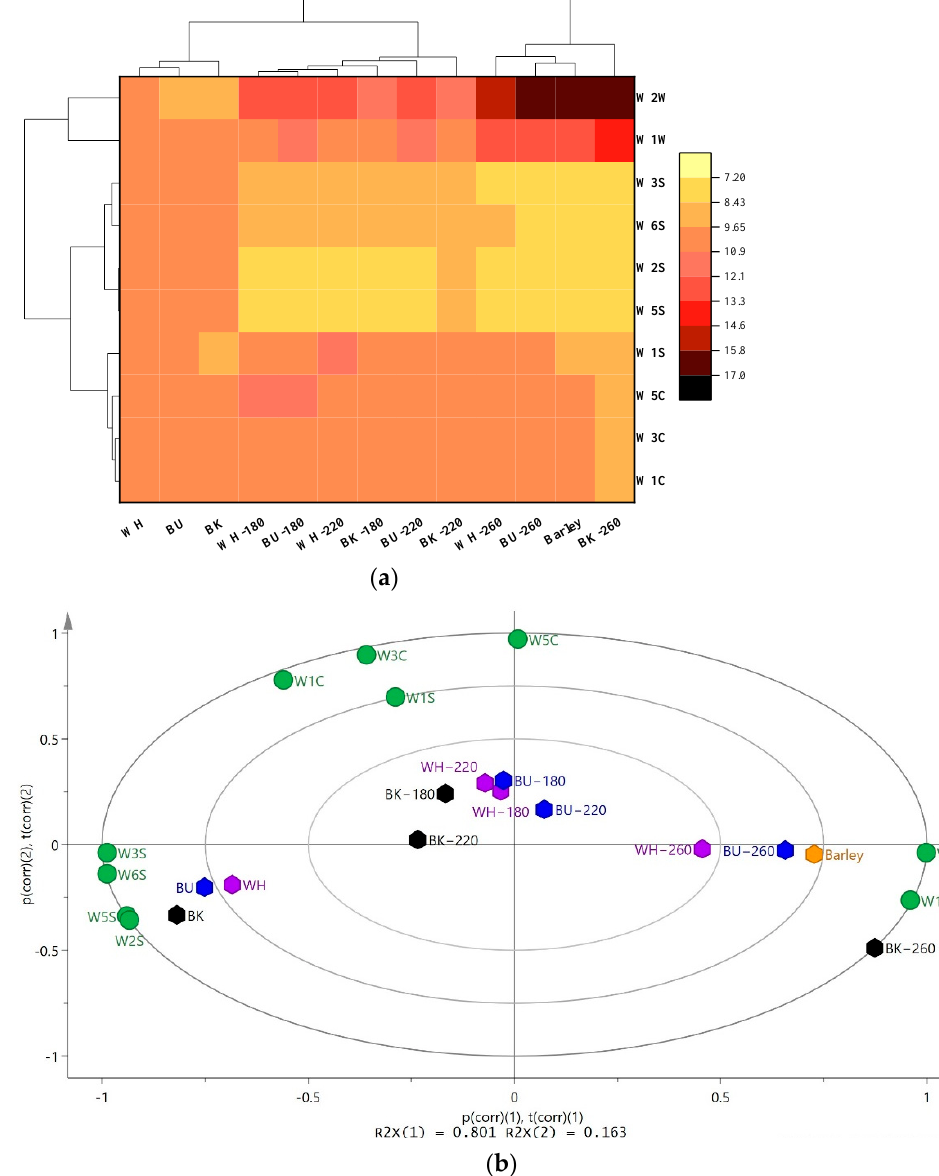
Figure 1. Heatmap clustering ( a ) and biplot of PCA ( b ) of the volatile aromas attributed by E-nose in the raw and CHB roasted at different temperatures.